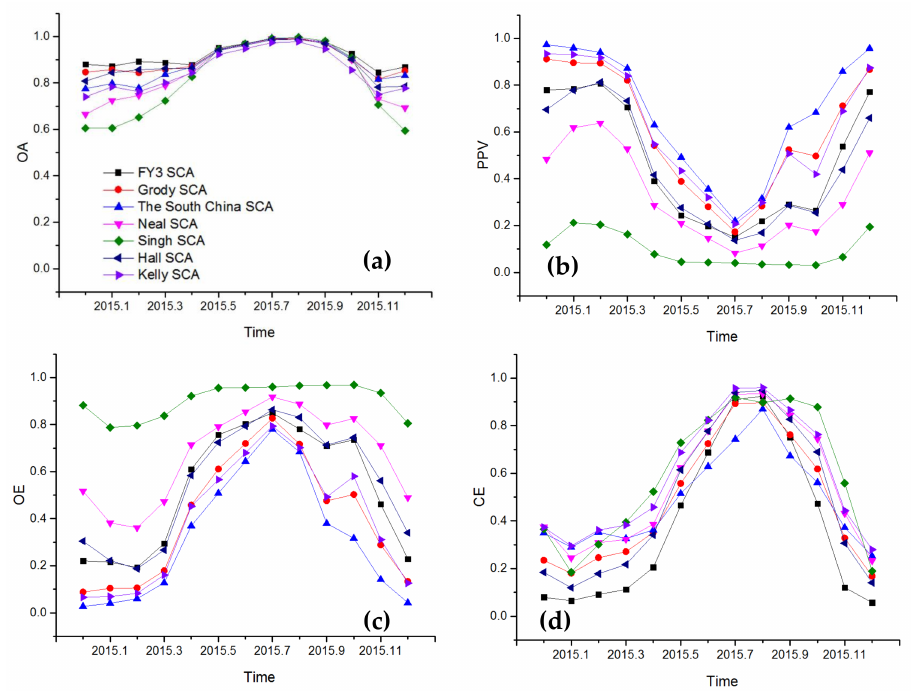
Figure 4. Monthly OA ( a ), PPV ( b ), OE ( c ) and CE ( d ) of the seven PMW SCA maps based on the IMS snow cover